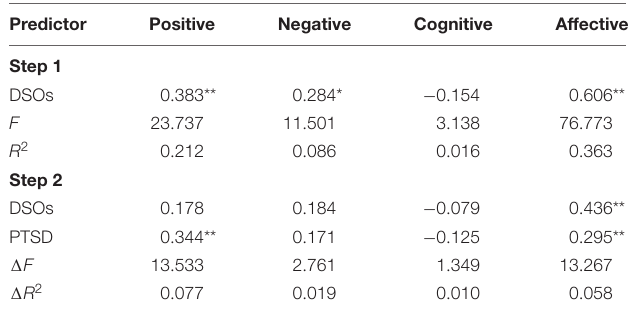
Frontiers in Psychology |